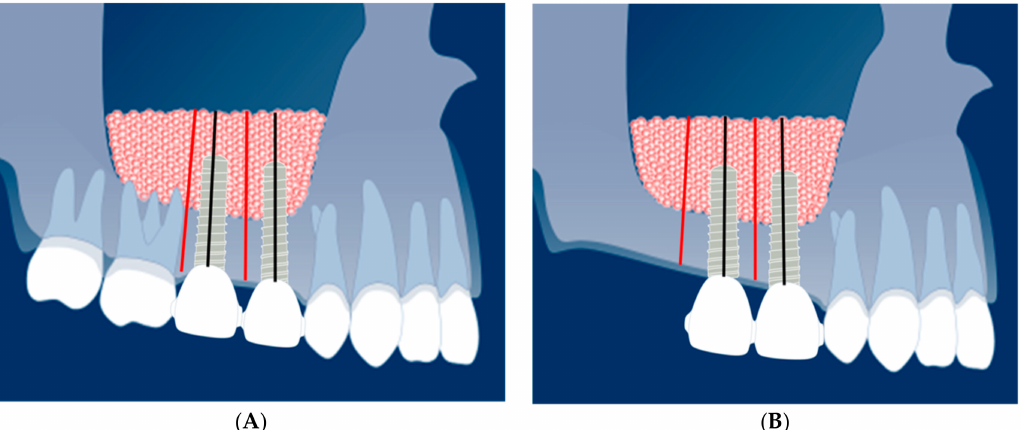
Figure 1. ( A ) This graphic shows the tissue height measurements at inter-implant positions. The black lines indicate the measurement positions at implant sites; the red lines (2–3 mm distally) the “distal” or intermediate positions. ( B ) This graphic shows the tissue height measurements at distal positions (free-end situation). The black lines indicate the measurement positions at implant sites; the red lines (2–3 mm distally) the “distal” positions. Source: graphic used with courtesy of the ITI Foundation, Basel,